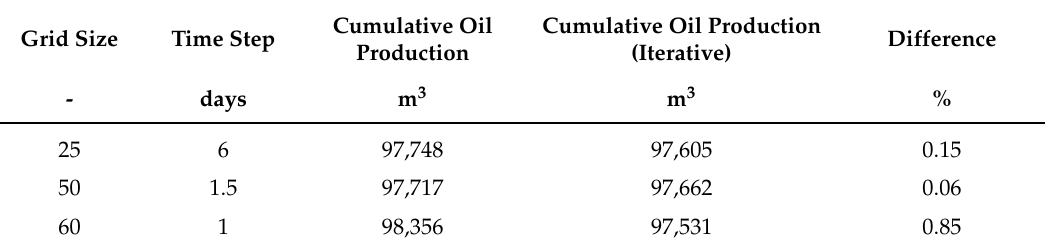
Table 6. Comparison of waterflooding process with non- and iterative IMPEC